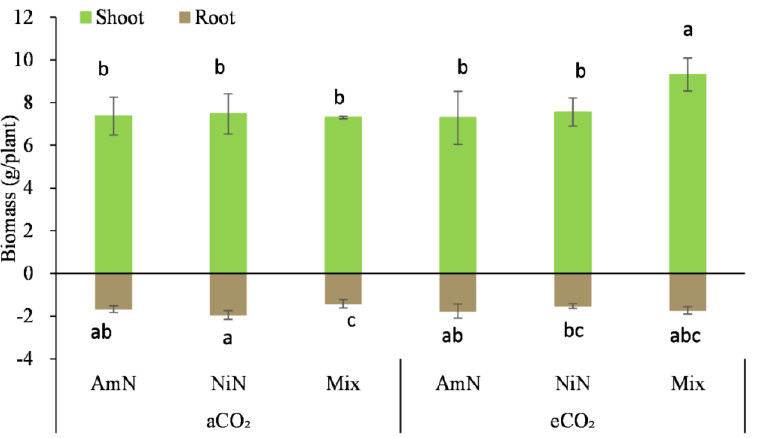
Figure 2. Biomass of maize supplied with different N forms under two atmospheric CO 2 concentra- tions. Note: (1) AmN denotes Ammonium N, NiN denotes Nitrate N, Mix denotes Mixed N; (2) aCO 2 denotes the ambient atmospheric CO 2 concentration at 390 µmol/mol; eCO 2 denotes the enriched atmospheric CO 2 concentration at 690 µmol/mol; (3) Different letters mean significant differences at p < 0.05 level for each indice; (4) Statistical analyses for above− and belowground are conducted separately; (5) Error bars are the standard deviation of five replicates. Table 5. Two − factor ANOVA analyses for maize biomass. Maize Shoot Biomass Root Biomass CO 2 n.s. n.s. N n.s. n.s. CO₂ × N n.s. * Note: n.s. means not significant among different indices at a 5% statistical level; * indicates a signif-